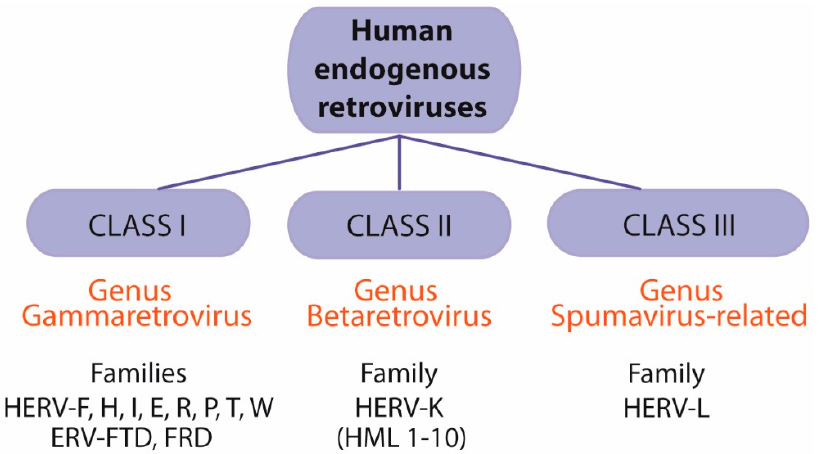
Figure 4. Classification of human endogenous retroviruses (HERVs). HERVs can be classified into three groups: class I (genus Gammaretrovirus), class II (genus Betaretrovirus), and class III (genus Spumavirus-related). Genus Gammaretrovirus includes families HERV-F, H, I, E, R, P, T, W as well as ERV-FTD and FRD. Genus Betaretrovirus includes the HERV-K family (HML1-10 subfamilies). Genus Spumavirus-related family includes the HERV-L family.